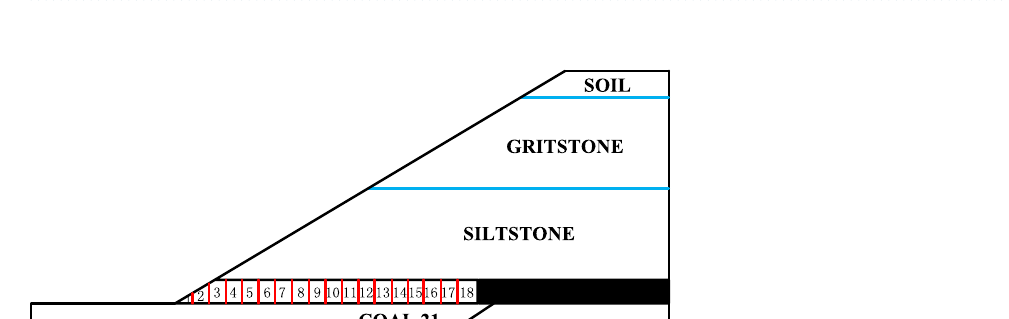
Figure 7. High mining area division.